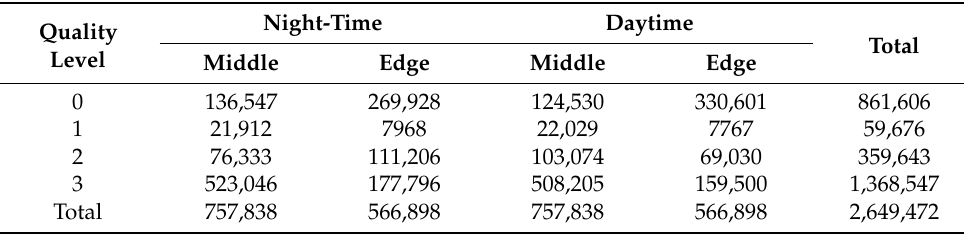
Table 2. Number of analysed